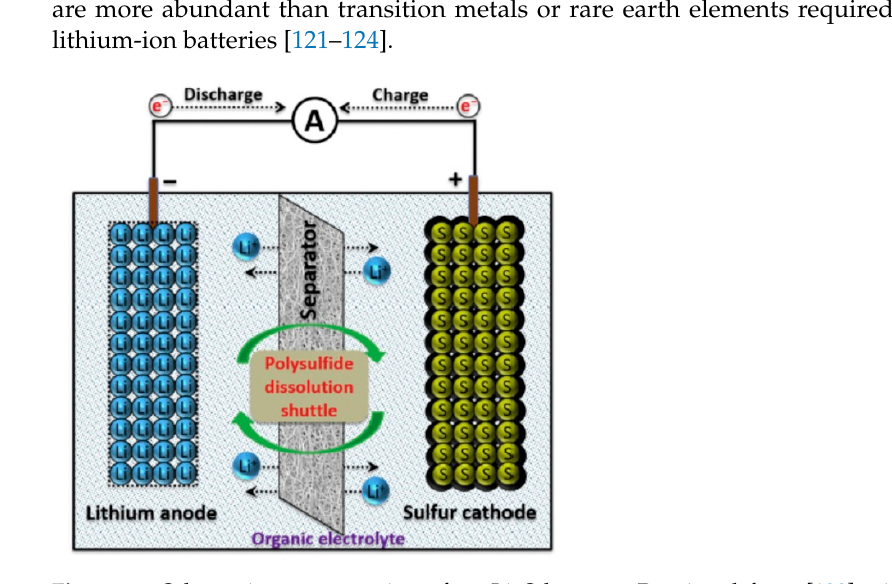
Figure 8. Schematic representation of an Li–S battery. Reprinted from [120] with permission from Elsevier.